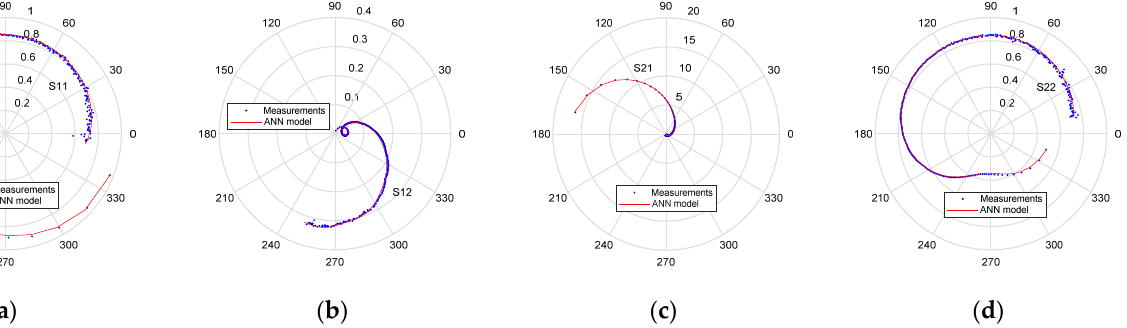
Figure 12. Measured (blue symbols) and ANN simulated (red lines) behavior of ( a ) S 11 , ( b ) S 12 , ( c ) S 21 , and ( d ) S 22 with the frequency range spanning from 200 MHz to 65 GHz for the DUT at V DS = 30 V, V GS = − 3.1 V, and T a = 145 °C.